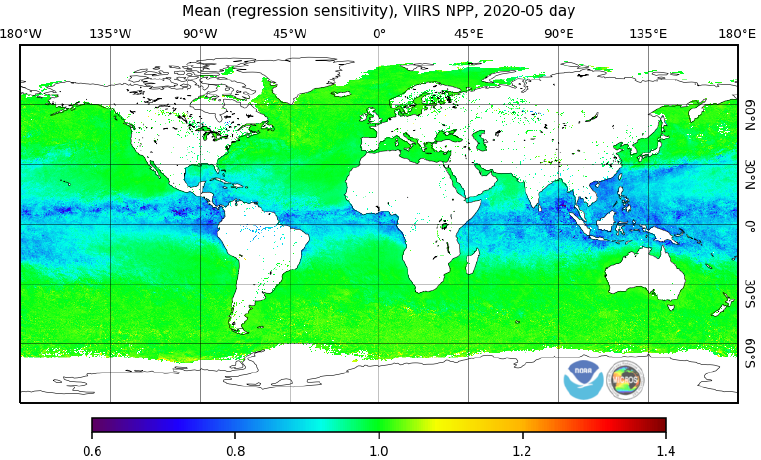
Figure 1. Monthly mean sensitivity (on a 0.1° × 0.1° latitude/longitude grid) for ACSPO V2.80 NPP VIIRS daytime ‘subskin’ SST for May 2020. In most cases, it is close to 1 (except in the tropical regions, and especially at slant VZAs, where atmospheric humidity is high, and the sensitivity can be as low as 0.8).